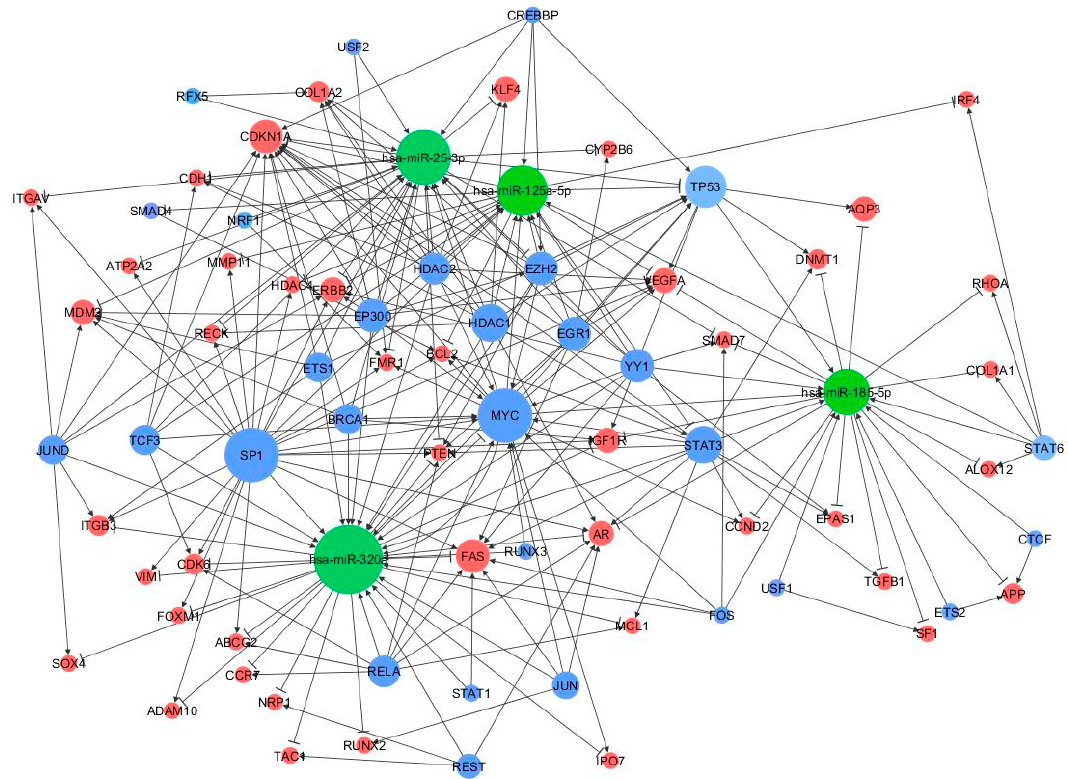
Figure 5. MiRNA-TF co-regulatory network. MiRNAs, genes and TFs are represented in green, red, and blue, respectively. Connections between the main players of the network are depicted by lines where the edges reflect the regulator mechanism, the arrows represent activation, and the perpendicular bars represent repression. The size of node is proportional to the degree of the node, i.e., the number of incoming and outgoing edges.